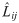
Comparison on the Rosetta Dataset.Comparison of the estimations of the 64 entries of the total causal effects matrix L using the exact expectation values 〈Lij〉 (from a complete enumeration) and estimates L^ij obtained from the three approaches: pairwise sampling, triplet-wise sampling, and a subset of the exact sample. For each matrix entry, the average value obtained via one of the three approaches is shown, respectively, as a function of the exact expectation value. The data is taken from the module Rosetta data set (8 genes). The inset shows the mean-squared error e2 between averaged entry and exact expectation value, as a function again of the exact expectation values.